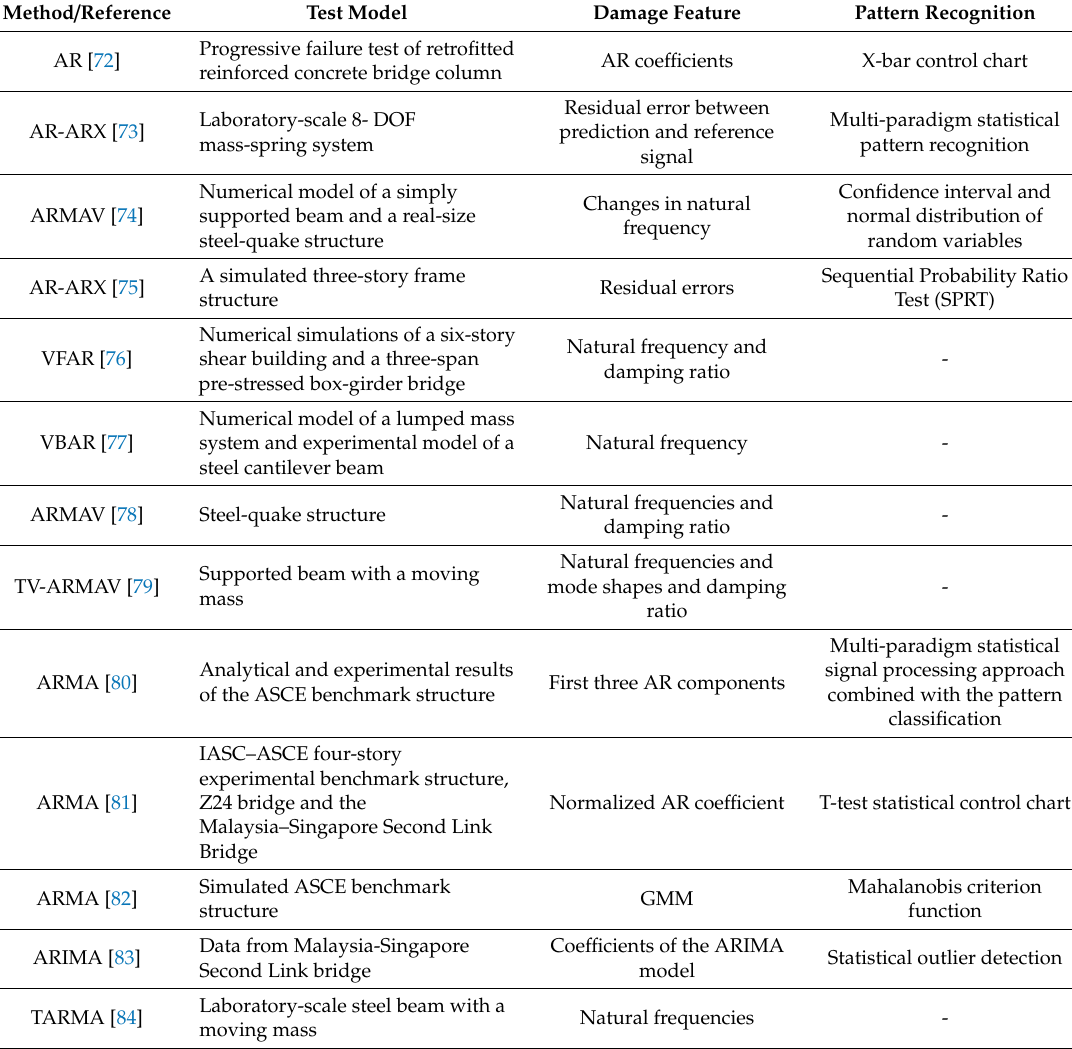
Table 2. Autoregressive-based methods applied in the structural health monitoring (SHM) of civil engineering